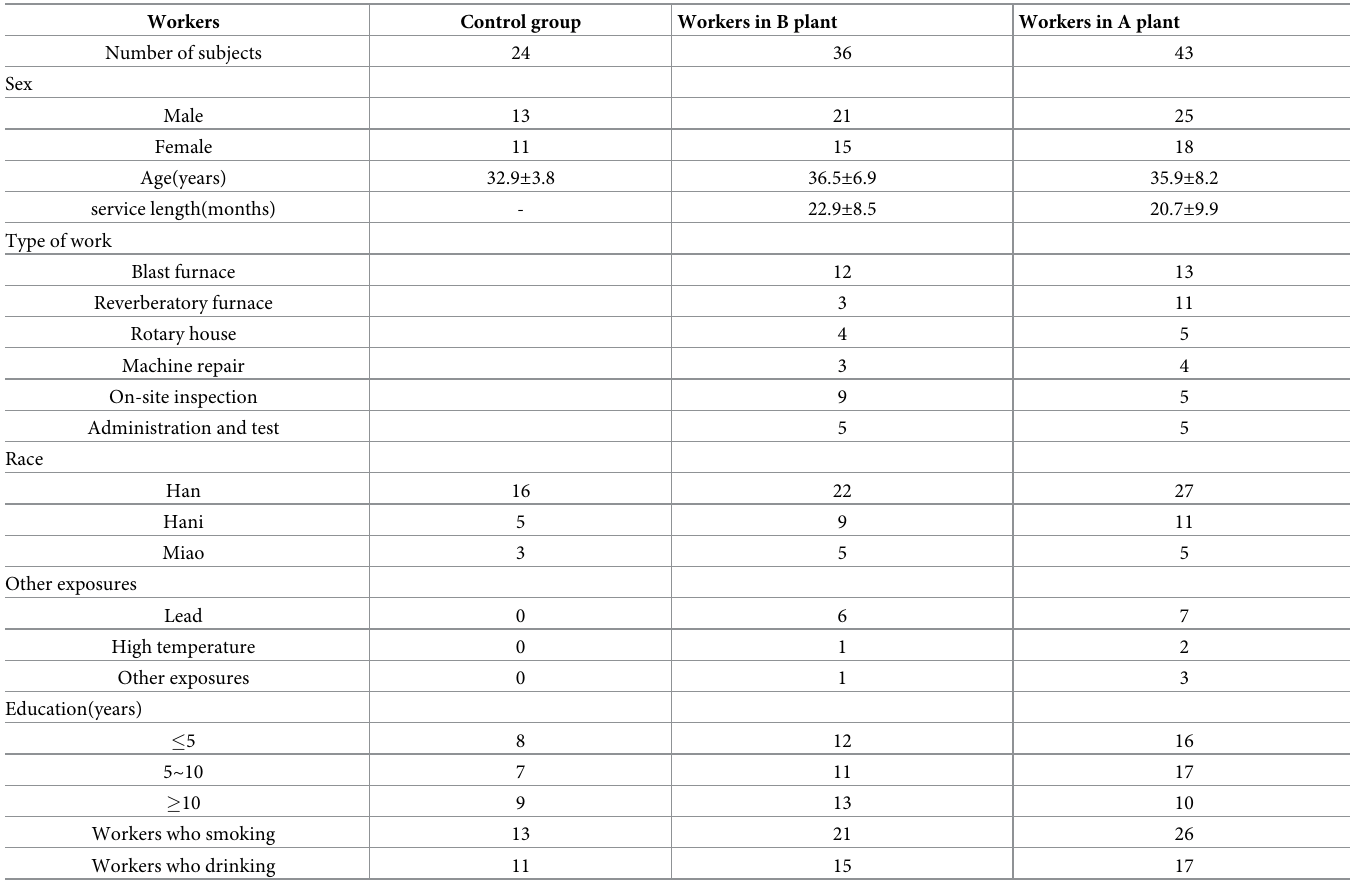
Table 1. Demographics of the study